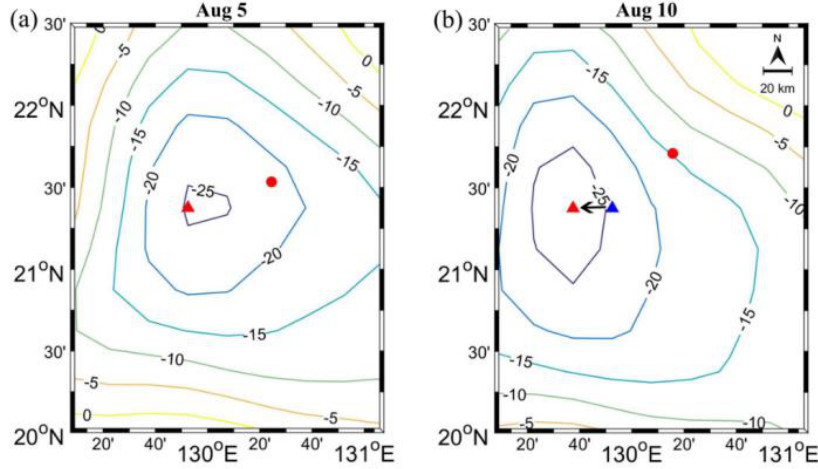
Figure 5. Negative SSHA (unit: cm) from AVISO, showing the position of the CE on 5 August ( a ) and 10 August ( b ) 2015. The red triangle and dot denote eddy center identified using the OW criterion and position of the Argo float on the same date. The blue triangle in ( b ) denotes the eddy center on 5 August, indicating the westward movement of the eddy.